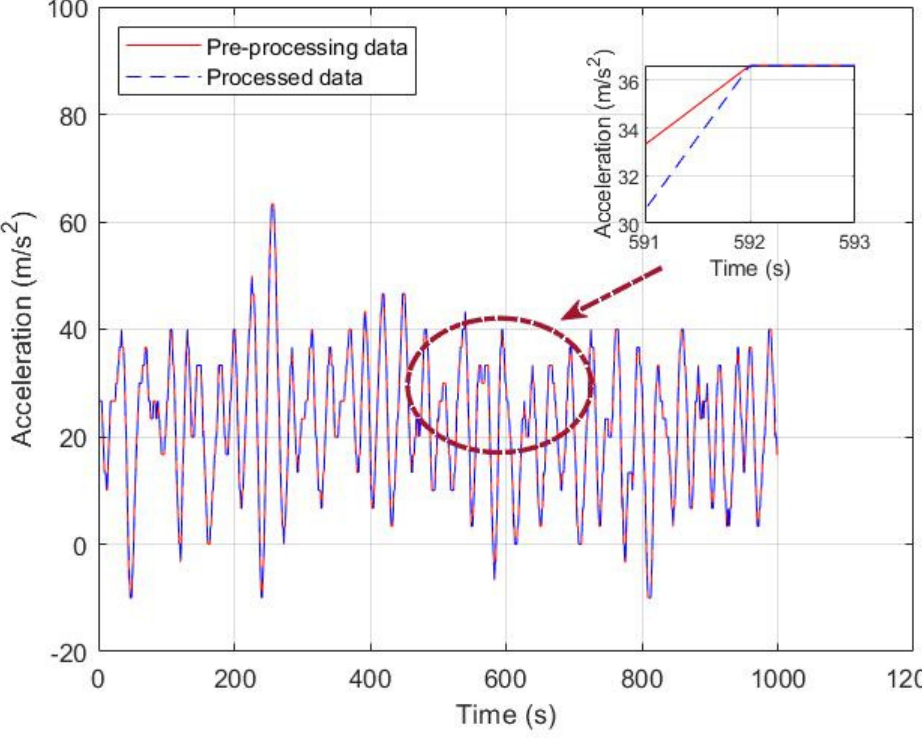
Figure 1. Processing of sampled data (accelerometer).